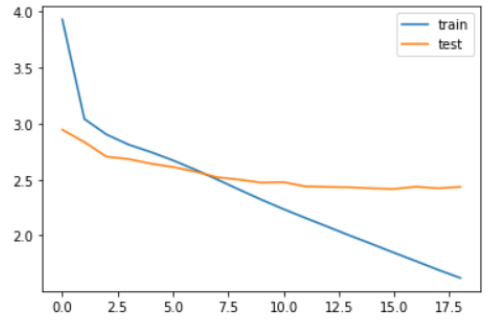
Figure 1. Flow of Extractive summary generation